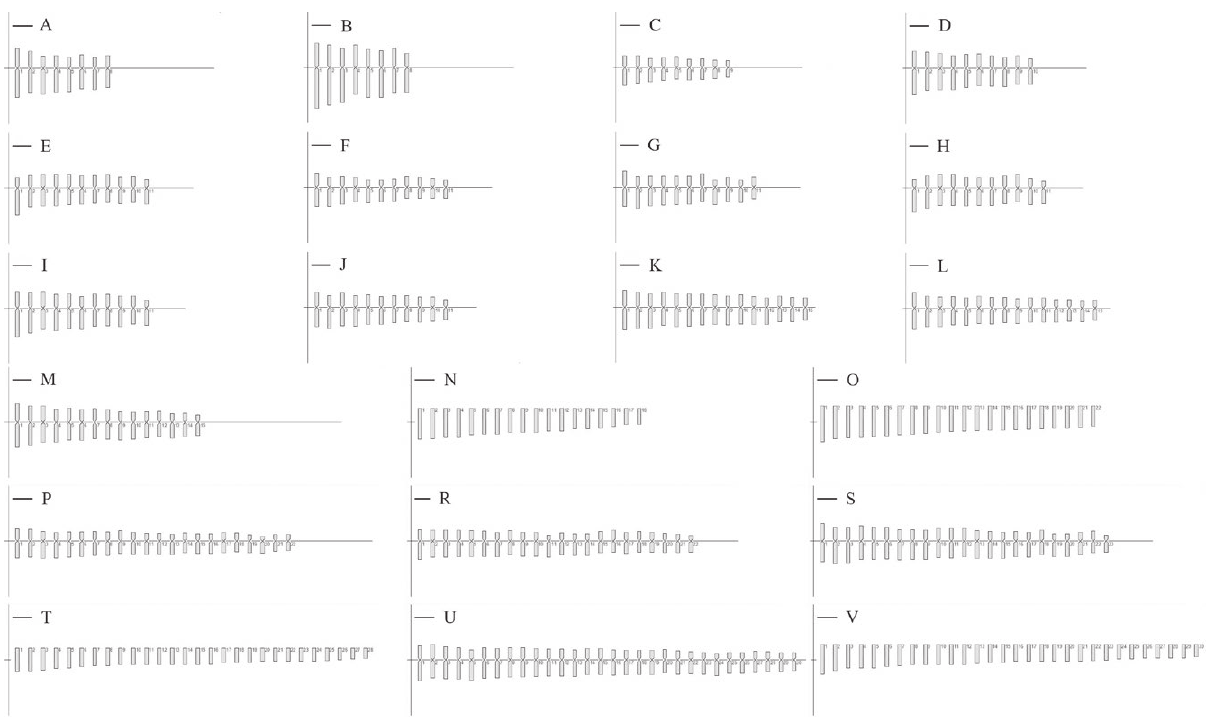
Figure 2. Ideograms of Salvia : (A) S. corrugata , (B) S . campanulata , (C) S . curviflora , (D) S . elegans , (E) S . darcyi , (F) S . greggii , (G) S . invo- lucrata , (H) S . longifolia , (I) S . vitifolia , (J) S . mexicana , (K) S . apiana , (L) S . leucophylla , (M) S . mellifera , (N) S . cardiophylla , (O) S . cuspi- data , (P) S . splendens , (R) S . subrotunda , (S) S . microphylla , (T) S . oppositiflora , (U) S . stolonifera , (V) S . atrocyanea (scale bars: 1